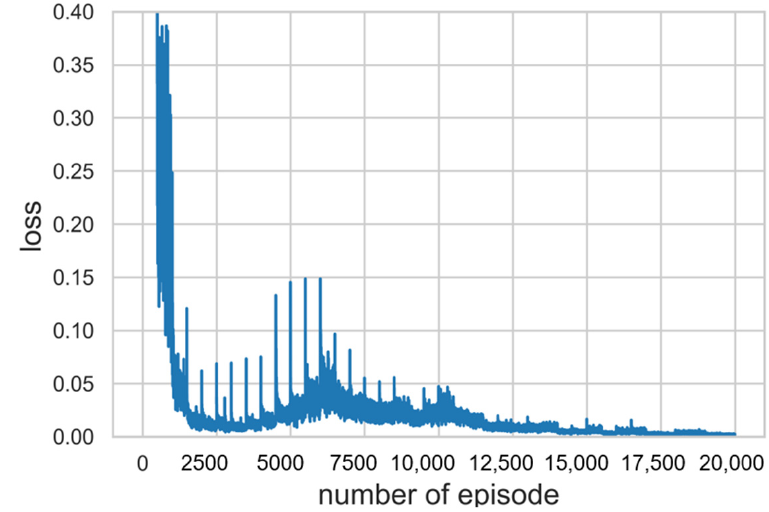
Figure 7. Loss values at each episode under 0.4. It was confirmed that the loss function gradually converges close to zero as well.